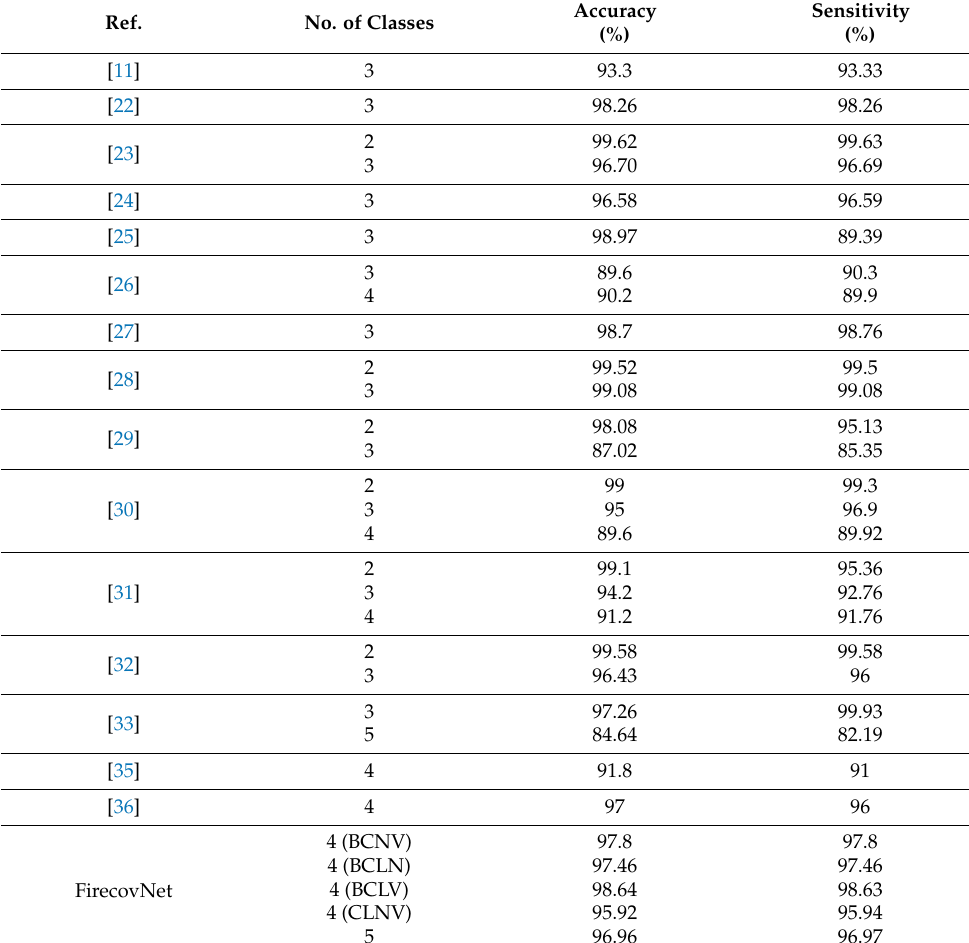
Table 8. Comparison of the FirecovNet results with other state-of-art studies.